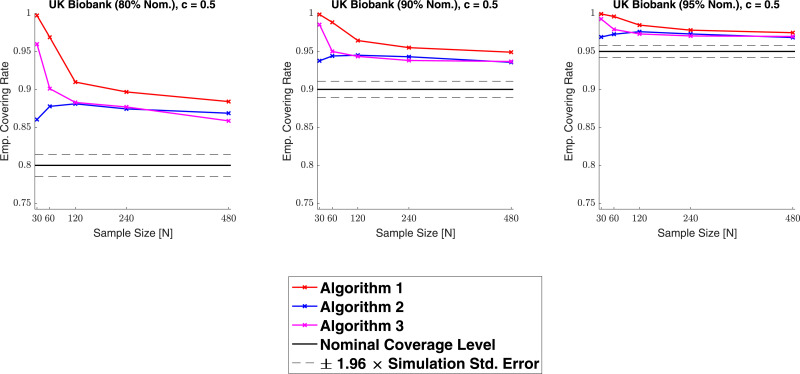
Coverage results for the UK Biobank signal type simulation with a Cohen’s d threshold of c=0.5 (instead of the c=0.8 threshold used for the simulation results presented in Fig. 11). For this smaller threshold, we observed valid, over-coverage for all three methods across all sample sizes, and on-the-whole the CSs performed well. In comparison to the results obtained for the larger threshold of c=0.8 (Fig. 11), it is notable that there is a slightly higher degree of over-coverage across all of the results here. We believe this may be in part due to inaccuracies in the interpolation method used to assess the simulations results, rather than inaccuracies in the method itself; as the boundary length ∂Ac is longer for the smaller threshold used here, it is more likely that violations of coverage were missed (due to the fact coverage is assessed at only a discrete set of lattice points along ∂Ac), inducing a positive bias in the results. We discuss this issue in more depth at the end of Section 5.2.